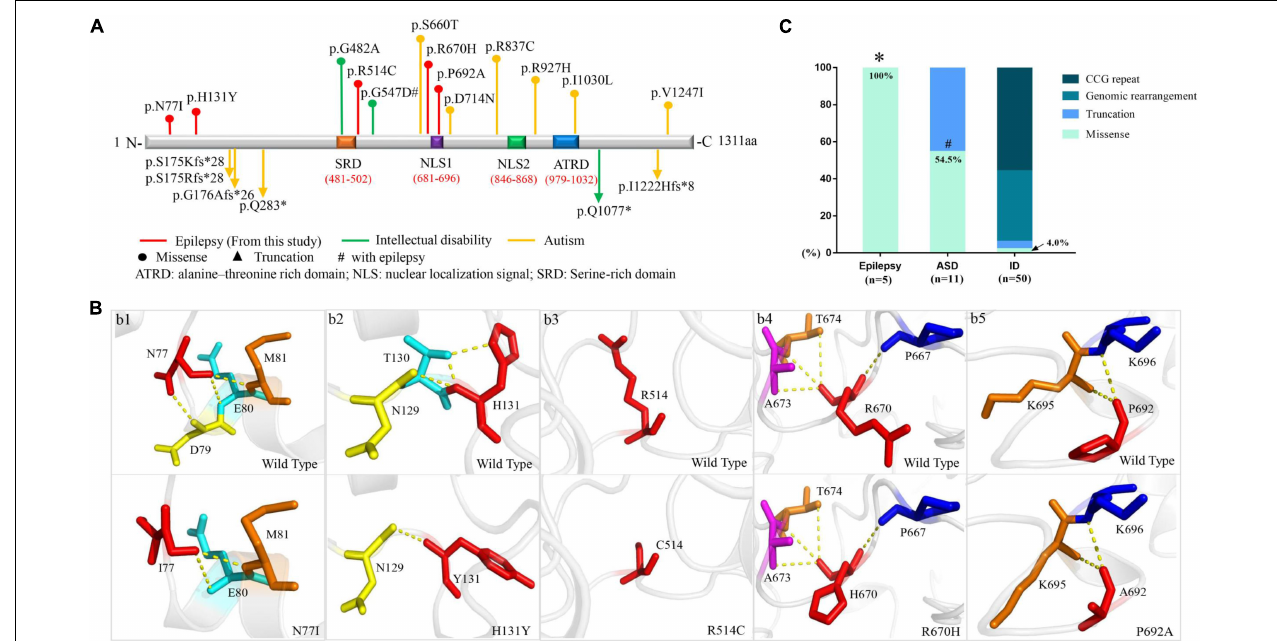
FIGURE 2 | Schematic presentation of FMR2 structure and genotype-phenotype correlation of AFF2 . (A) Schematic diagram of missense and destructive AFF2 mutations and their locations on FMR2 protein. Missense mutations were shown at the top of the structural diagram. Destructive mutations were shown at the bottom. (B) Schematic illustration of the changes in hydrogen bonds. The residues where the mutations occurred are shown as red rods. The hydrogen bonds are shown as yellow spheres. (C) Genotypes of AFF2 in epilepsy, autism spectrum disorder (ASD), and intellectual disability (ID). *The proportion of missense mutations in epilepsy is significantly higher than that in ID ( p < 0.001) through Fisher’s exact test. # The proportion of missense mutations in ASD is significantly higher than that in ID ( p < 0.001) through Fisher’s exact